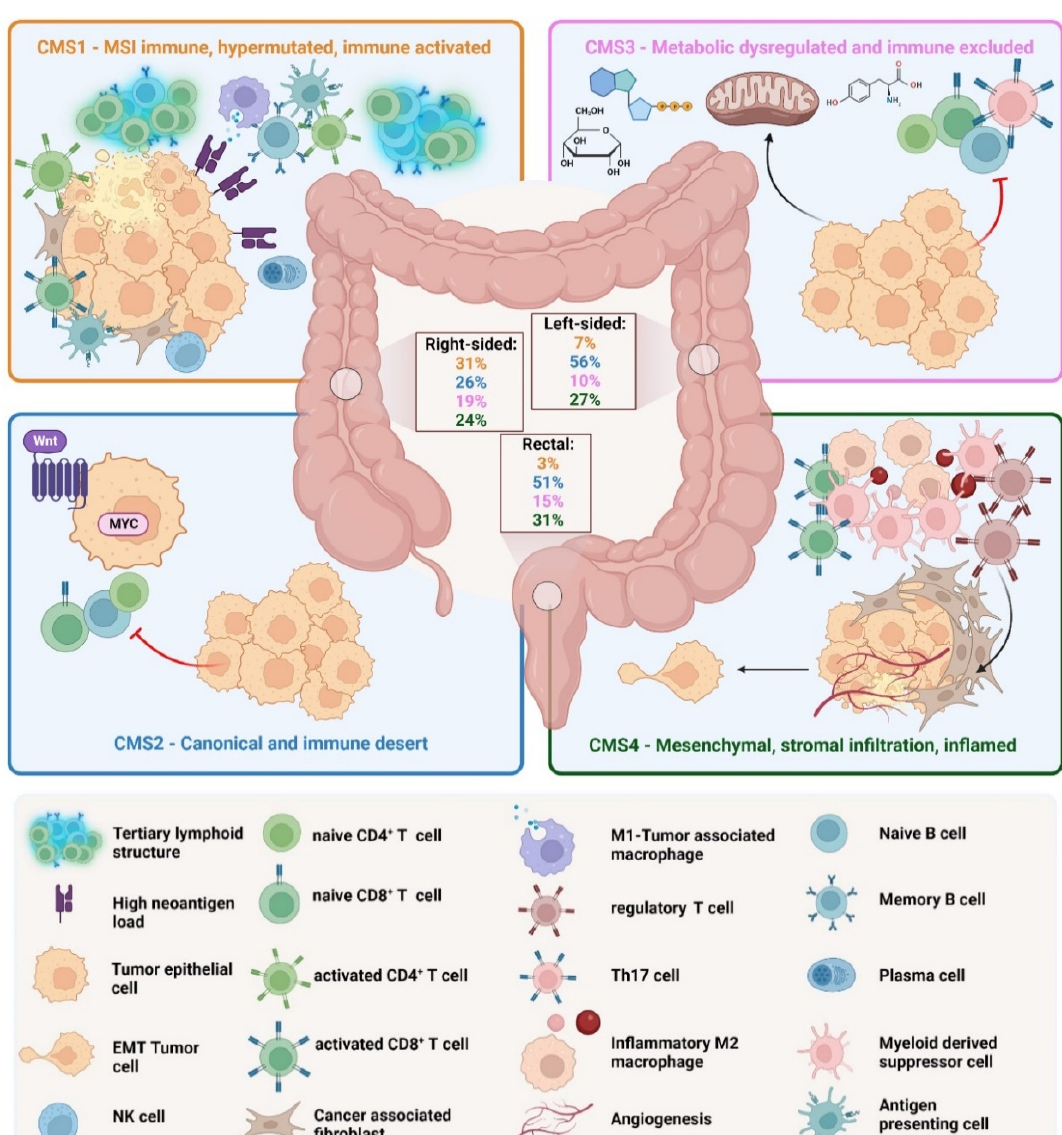
Figure 2. Consensus molecular subtypes of CRC. CMS1, the MSI immune subtype, is characterized by infiltration of lymphocytes and the formation of tertiary lymphoid structures. CMS2, the canonical subtype, is characterized by absent immune infiltration. CMS3, the metabolic subtype, is characterized by immune cell exclusion. CMS4, the mesenchymal subtype, is characterized by the infiltration and activation of mesenchymal cells such as